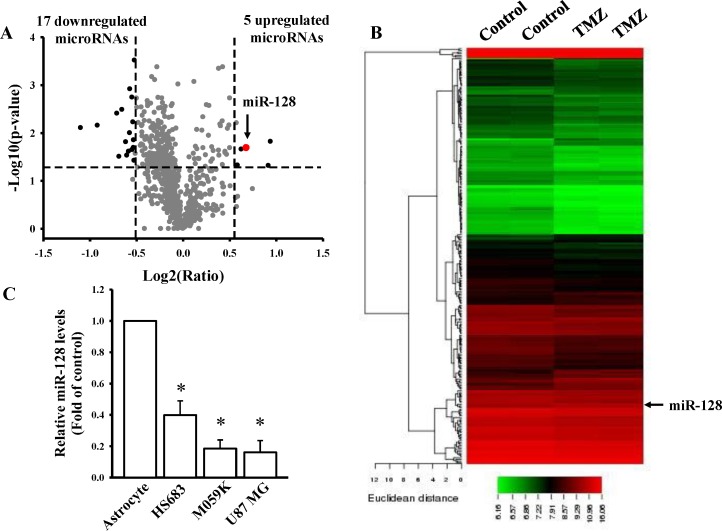
Investigation of TMZ-mediated microRNA profiles.Volcano plot (A) and heatmap of hierarchical gene clustering (B) demonstrating TMZ-regulated microRNA signatures. After U87MG cells were treated with 400 μM TMZ for 24 h, total RNAs were extracted for the microarray. For all array analyses, a p value of less than 0.05 and a log2 (ratio) of more than or equal to 0.58 or less than or equal to −0.51-multiple of change cutoff were applied. Volcano plots exhibit multiples of change (log2 ratio) and probabilities (-log10
p values) of individual microRNAs from the microarray assay. Significantly upregulated and downregulated mRNAs are indicated by black dots. The red dot indicates miR-128. The heatmap depicts the 248 differentially expressed microRNAs between TMZ subsets. A color was assigned to each microRNA based on its relative expression across samples. (C) Detection of endogenous miR-128 levels in normal human astrocytes and three different glioma cell lines including HS683, M059K, and U87MG cells. Relative expression levels of miR-128 were measured through real-time PCR. The U6B level was used as an internal control. Data are the mean ± SD of three experiments.